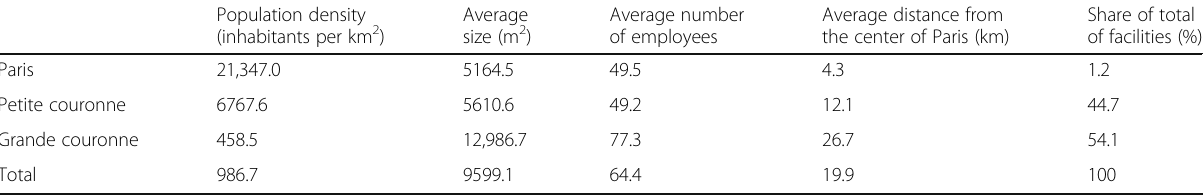
Table 2 Indicators on the general location of logistics facilities in Paris